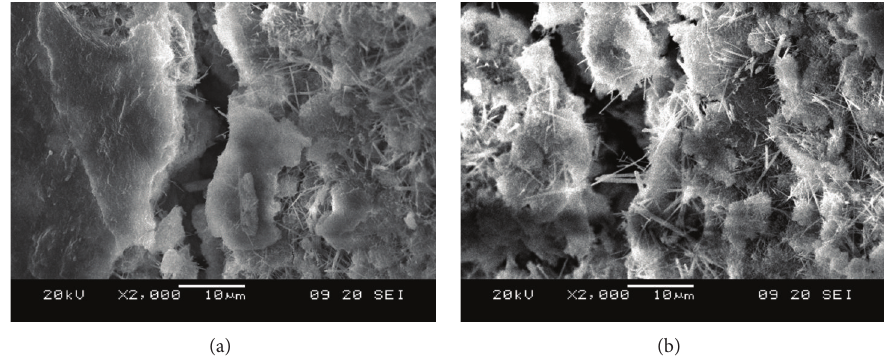
Figure 7: SEM images of concrete cores (a) cracking in the mortar and (b) pores in the